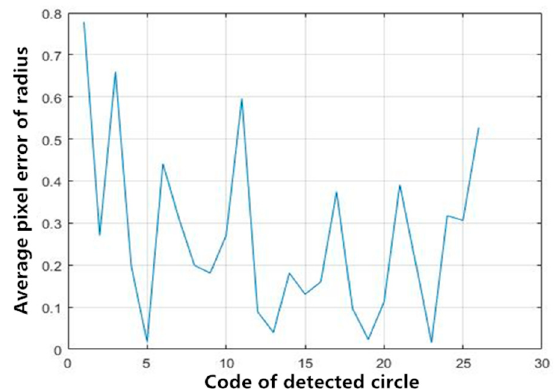
Figure 12. Average pixel errors of the radii of detected circles on the surface of engine cylinder head.